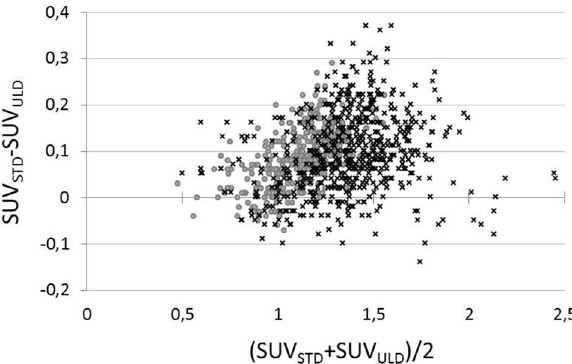
Figure 2. Bland–Altman plot of regional differences SUVR STD – SUVR ULD as a function of (SUVR